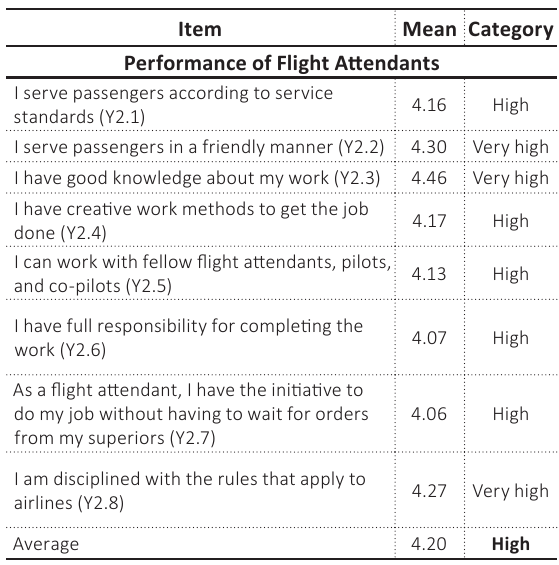
Table 3 (cont.). Answer frequency distribution